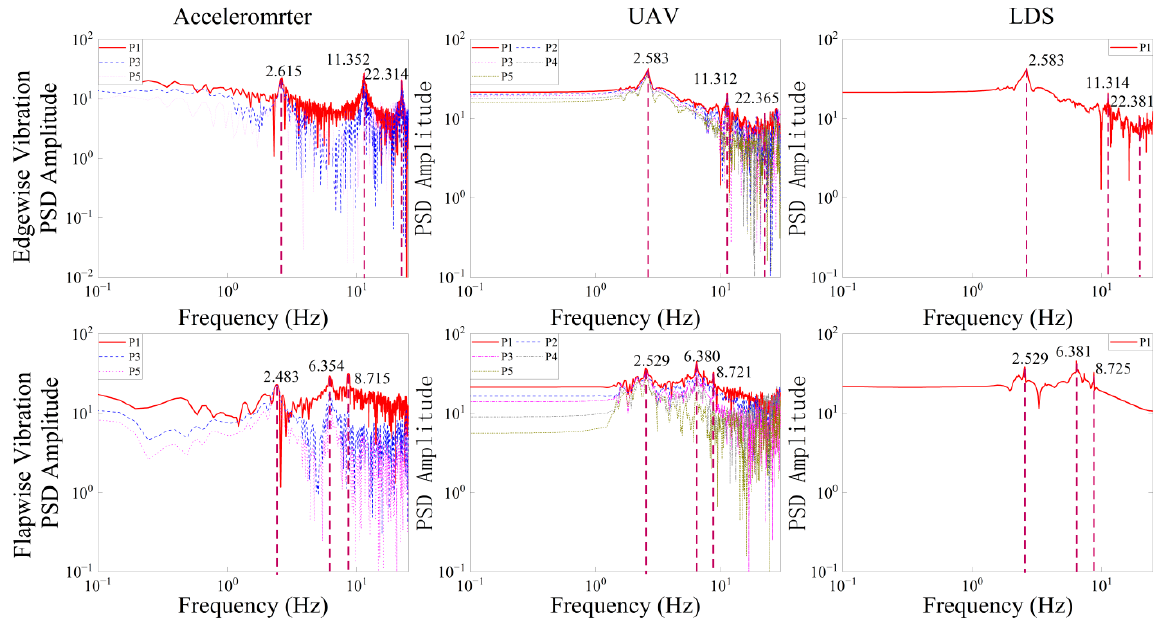
Figure 24. Frequency test results in edgewise and flap-wise direction.